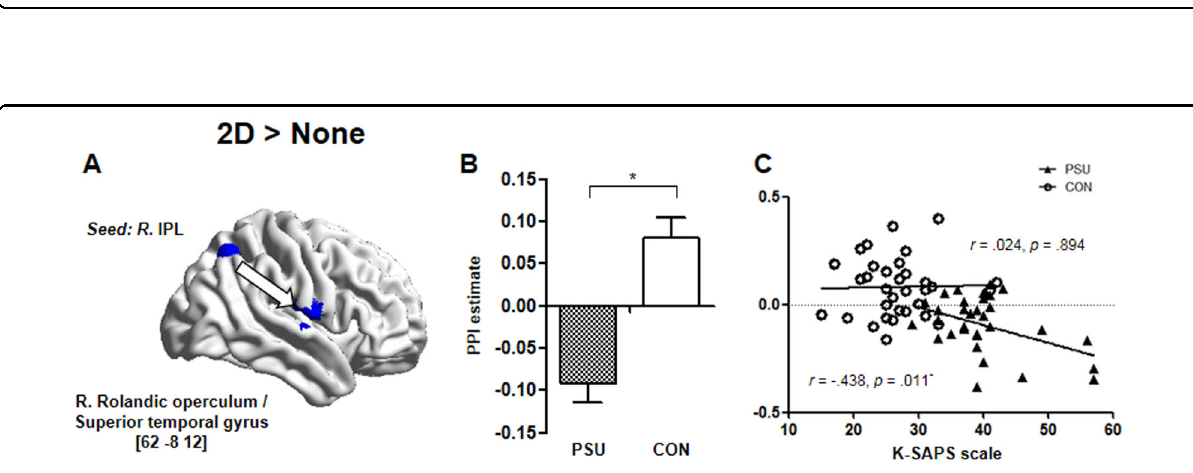
Fig. 4 The effect of problematic smartphone use on the functional connectivity of the right IPL in the presence of distracting stimuli during the behavioral performance. A , B Compared with the CON group, the PSU group showed decreased functional connectivity between the right IPL and rolandic operculum/STG during the 2D condition relative to the None condition. * Signi fi cant at p < 0.05. C The PSU group demonstrated a negative association between the strength of this functional connectivity and the severity of the smartphone dependency measured by the K-SAPS scale. * Signi fi cant at p < 0.05. Error bars indicate SEM. CON control group, K-SAPS smartphone addiction proneness scale, developed by the Korean National Information Society in 2011, IPL inferior parietal lobule, PPI psychophysiological interaction, PSU problematic smartphone user